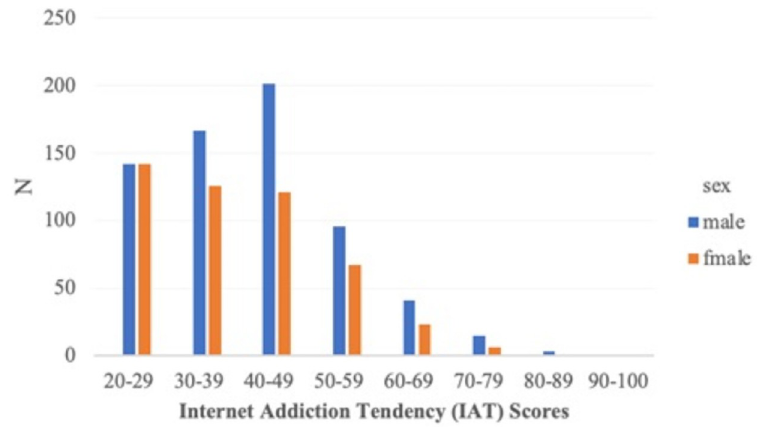
Fig 2. Distribution of internet addiction tendency (IAT) scores.